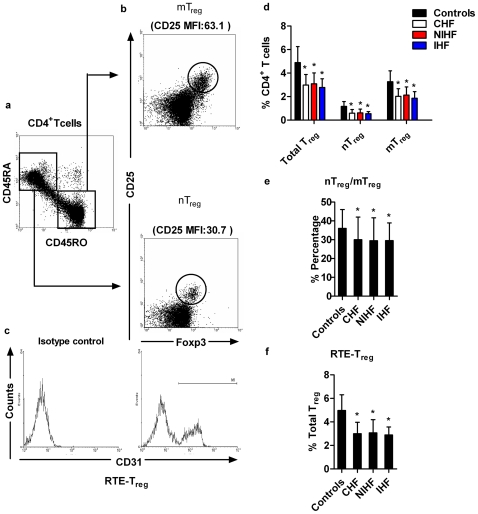
Frequencies of the regulatory T (Treg)-cell subset in CHF patients and non-CHF controls.PBMCs of CHF patients (n = 52, 32 NIHF and 20 IHF) and non-CHF controls (n = 43) were included, and a 6-color flow cytometric analysis using mAbs specific for CD4, CD25, CD45RA, CD45RO, CD31 and Foxp3 was performed. a. Representative FACS images from a non-CHF control. Dot plots show CD45RA and CD45RO expression on gated CD4+ T cells. Naïve and memory CD4+ T cells were defined as CD45RA+CD45RO− (R1) and CD45RA−CD45RO+ (R2), respectively. b. A small subpopulation of memory Treg (mTreg) (upper panel) and naïve Treg (nTreg) (lower panel) cells expressing both CD25 and Foxp3 was detectable. c. Histograms show the expression of CD31 on nTreg cells. Recent thymic export-Treg (RTE-Treg) cells were identified as CD4+CD25+Foxp3+CD45RA+CD45RO−CD31+ cells. d. Frequencies of total Treg, nTreg, and mTreg cells in different patient populations were determined as percentages of total CD4+ T cells. e. The ratio of nTreg to mTreg cells in different subject populations. f. RTE-Treg cell frequency in different subject populations was presented as a percentage of total Treg cells. *p<0.05 vs. non-CHF controls.